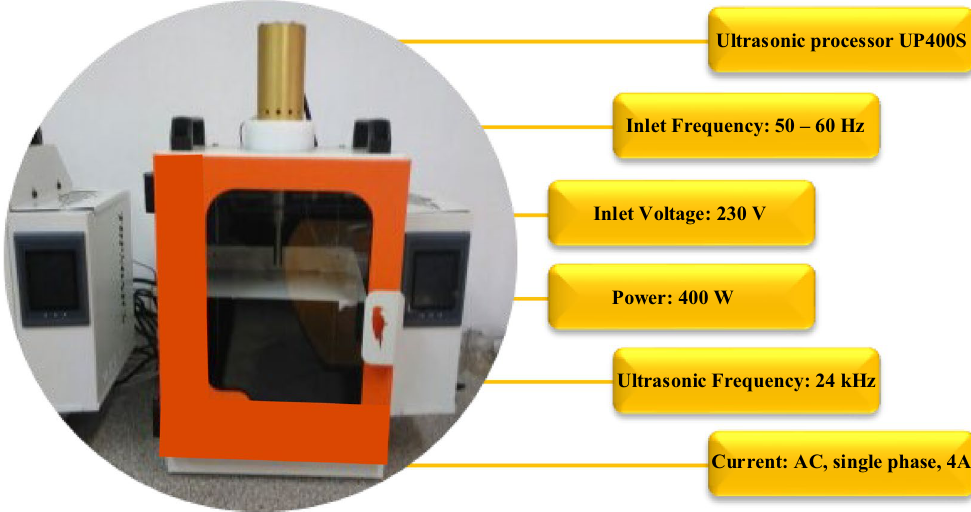
Figure 3. The ultrasonic bath device and ultrasonic processor specifications.